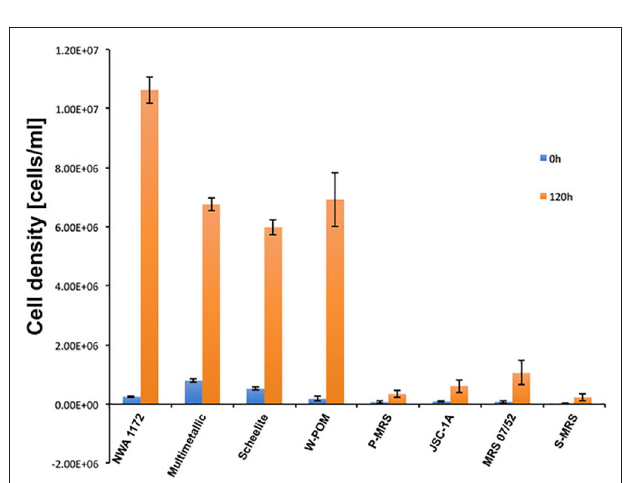
FIGURE 4 | Cell densities of M. sedula cells recovered after desiccation for 2 months. Blue bars represent cell counts after immediate re-cultivation in heterotrophic medium (“0”), orange bars represent cell counts after 120h of growth after re-culturing. Columns and error bars show the mean and error-represented standard deviation, respectively, of n = 3 biological replicates. If not visible, error bars are smaller than